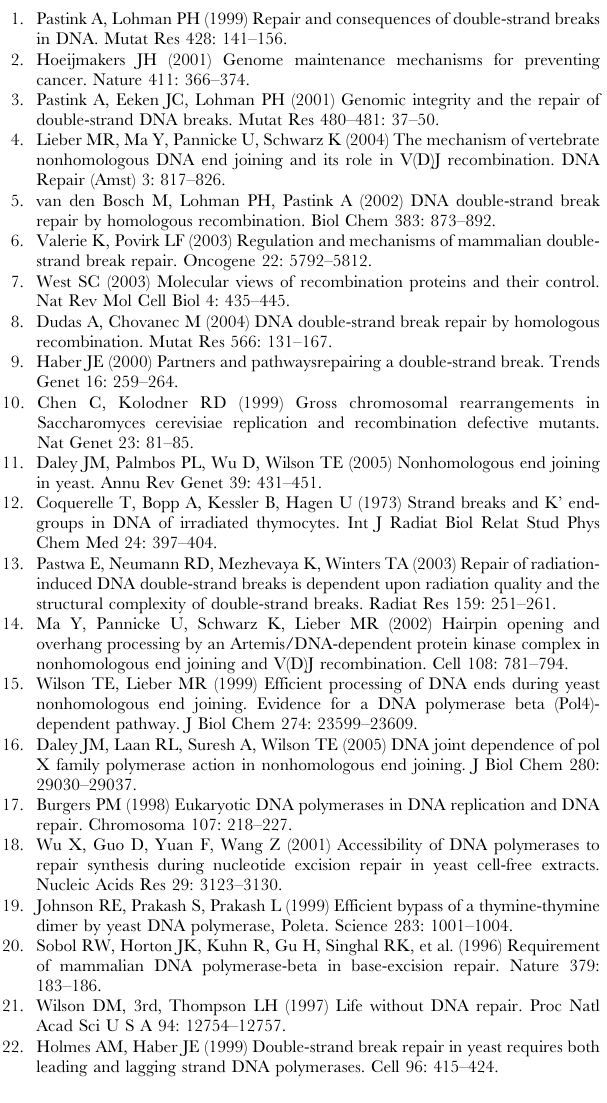
A3::ACT1 intron::HO cut site locus of non-essential DNA polymerase mutants.